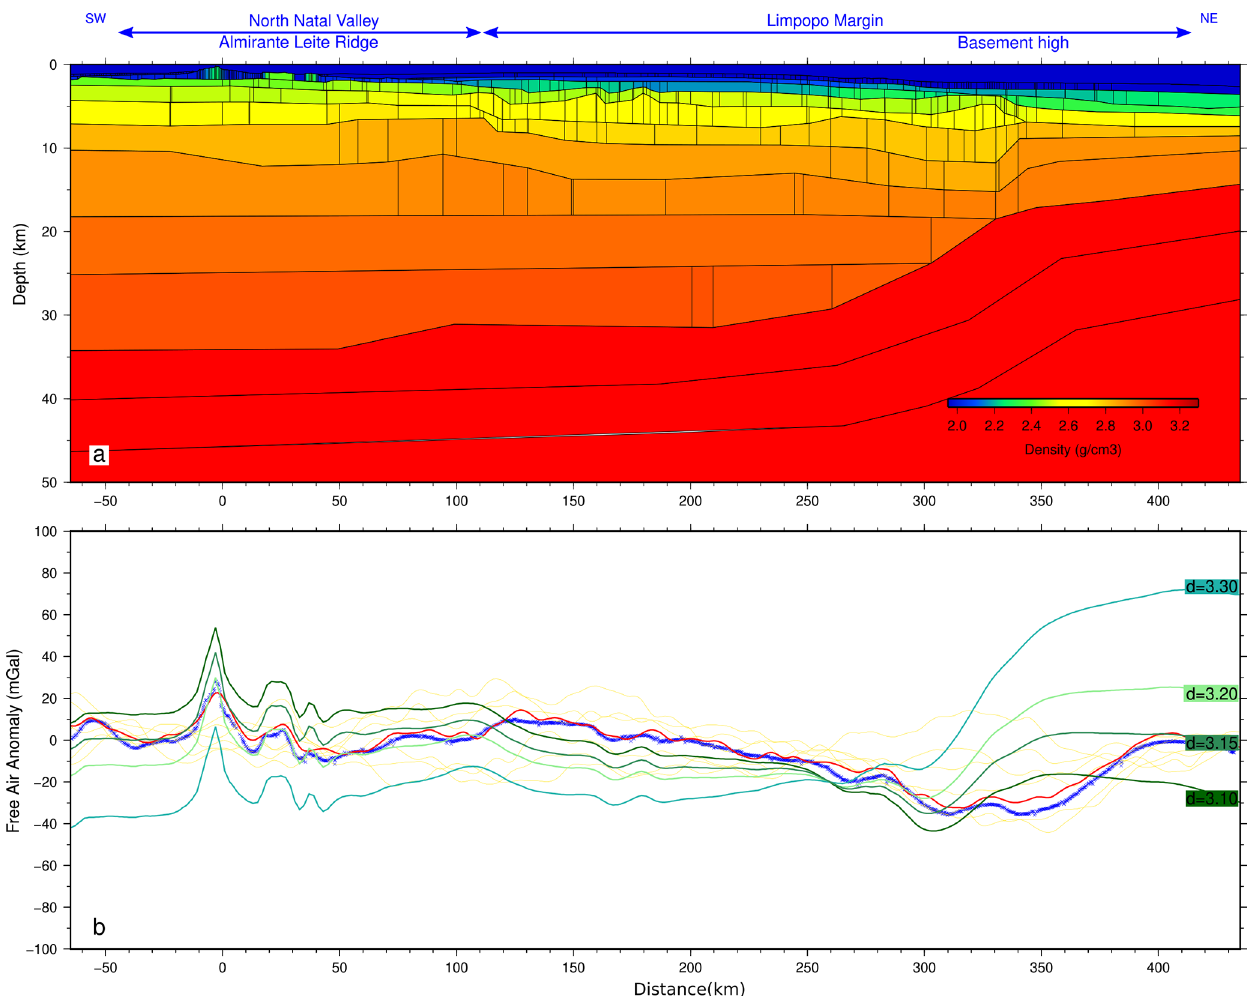
Figure 11. Gravity modeling along the MZ3 profile. (a) Density model showing blocks of equal density converted from the final velocity model according to empirical function (Ludwig et al., 1970). (b) Gravity anomaly along MZ3 profile. The free-air gravity anomaly derived from satellite altimetry (Pavlis et al., 2012) along the profile is in red, while yellow curves correspond to similar profiles extracted at 10, 20 and 30km laterally (yellow lines). The blue curve is the gravity anomaly measured during the MOZ35 experiment. Green curves are the calculated gravity anomaly from the converted model in (a) according to several mantle densities (green